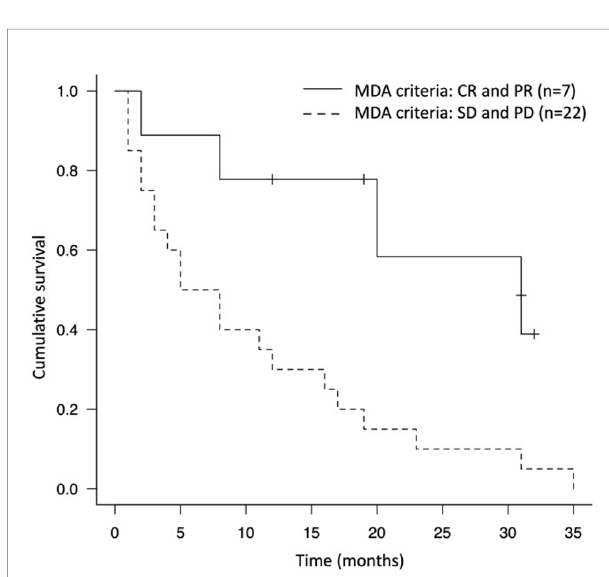
FIGURE 3 | Kaplan-Meier survival curve of the group that immune checkpoint inhibitor responded to bone metastatic lesions (MDA criteria evaluation was CR and PR) and the non-responded group (MDA criteria evaluation was SD and